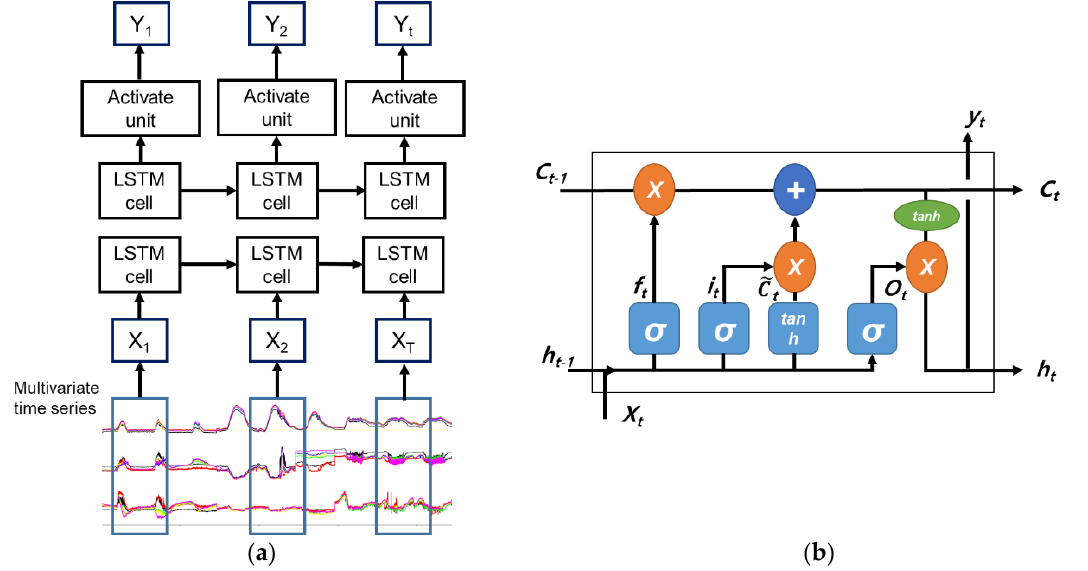
Figure 2. The ET prediction model structure based on long short-term memory ( a ); long short-term memory mechanism ( b ).